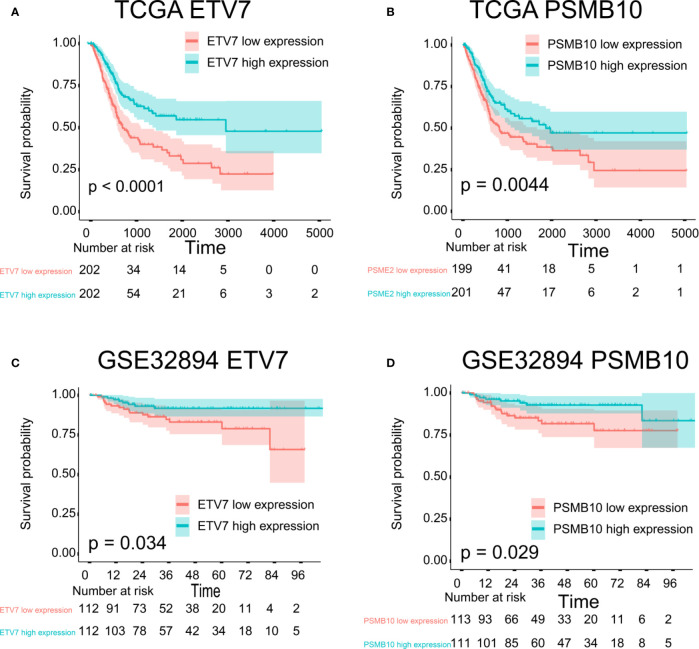
Survival analysis. (A) ETV7 survival analysis in TCGA, P < 0.0001. (B) PSMB10 survival analysis in TCGA, P = 0.0044. (C) ETV7 survival analysis in GSE32894, P = 0.034. (D) PSMB10 survival analysis in GSE32894, P = 0.029.